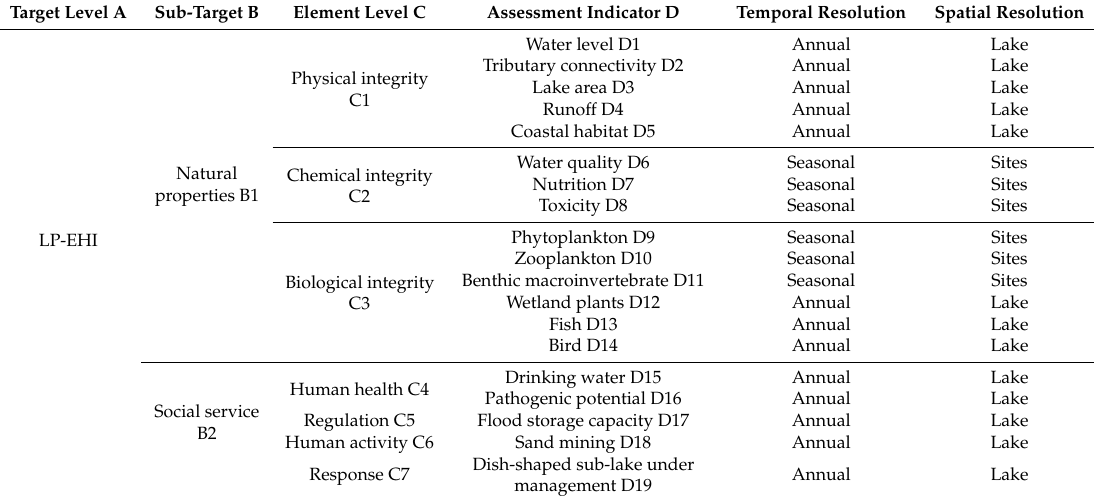
Table 3. Different temporal and spatial resolution of indices in